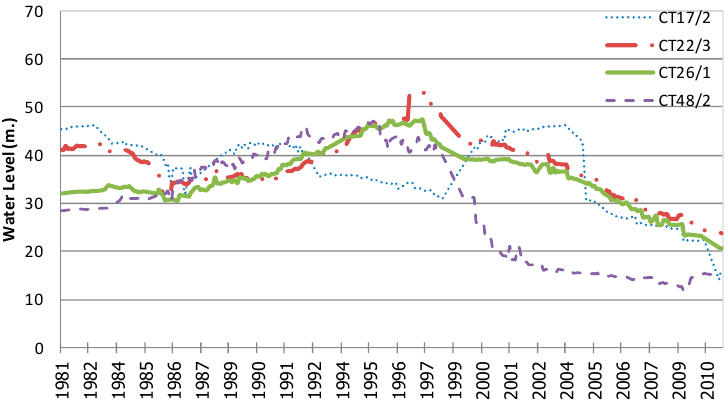
Figure 4 . Characteristics of groundwater levels at 4 sample stations. Figure 4. Characteristics of groundwater levels at 4 sample